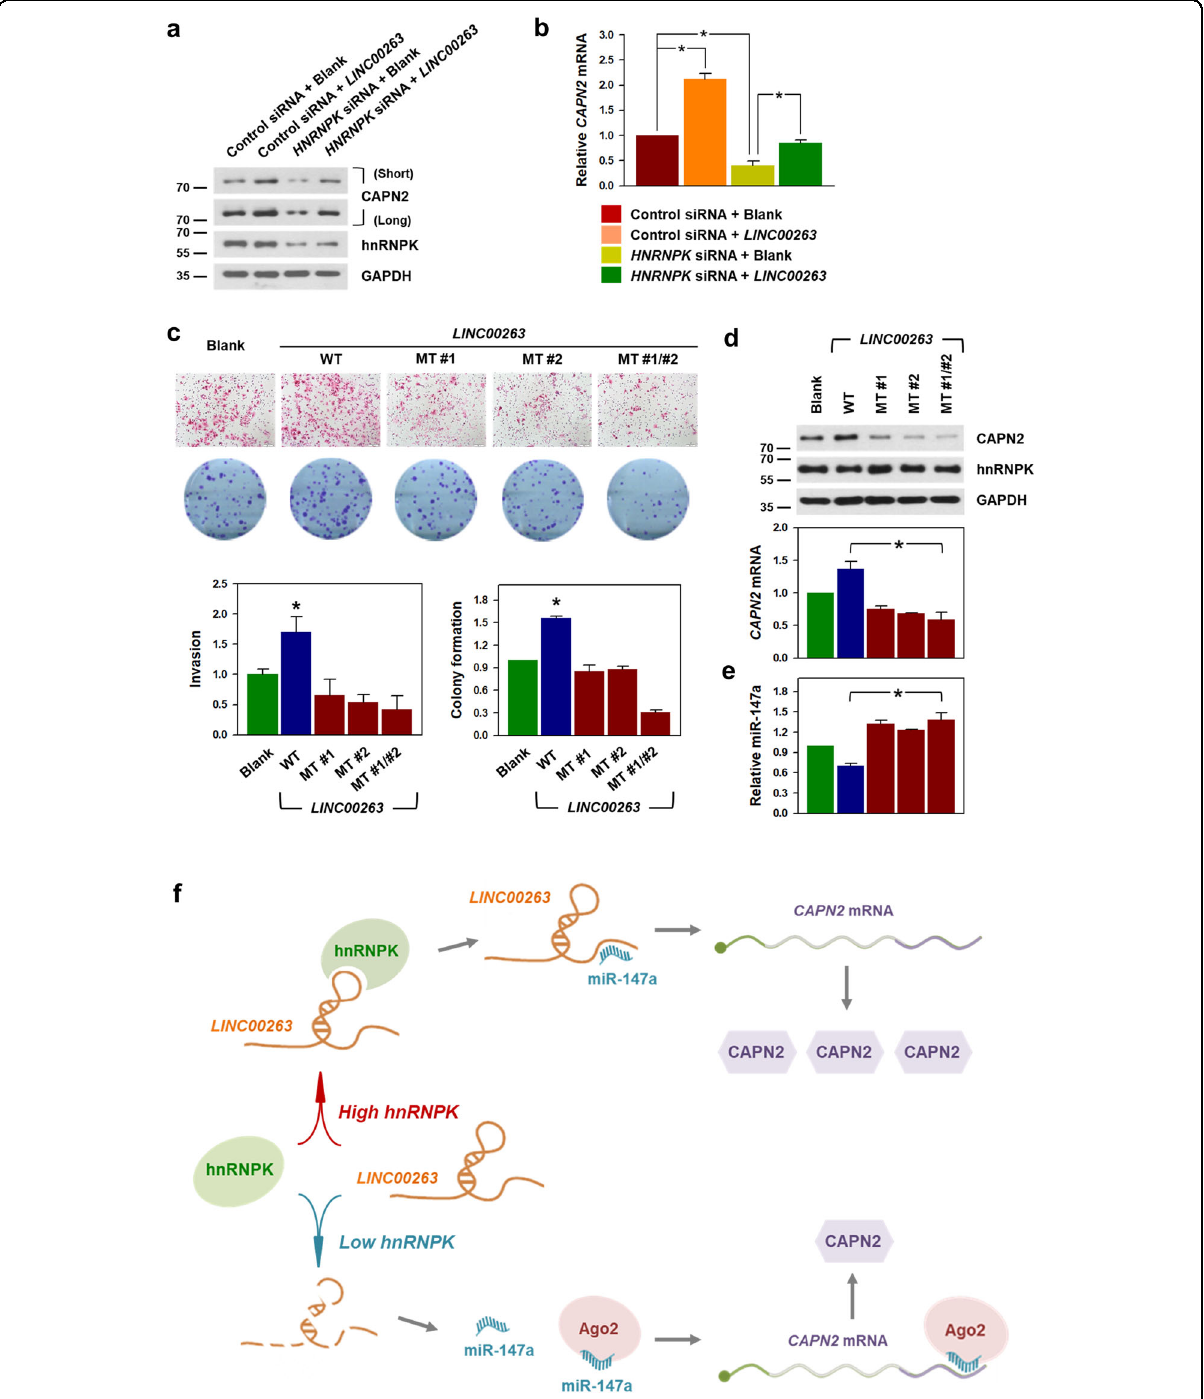
Fig. 7 The ability to sponge miR-147a is required for the oncogenic function of LINC00263 . a , b HeLa cells were transfected with HNRNPK siRNA and/or a LINC00263 expression vector. The expression levels of CAPN2 protein ( a ) and CAPN2 mRNA ( b ) were determined by Western blot and RT-qPCR analyses, respectively. c – e LINC00263 expression vectors harboring mutant sequences of both miR-147a MREs were constructed. As with constructing the luciferase reporter vectors, four nucleotides of each miR-147a MRE in LINC00263 were changed to block the binding of miR-147a. c The invasive and clonogenic effects of three mutated LINC00263 (miR-147a MRE mutant #1, #2, and #1/#2) were determined as described in “ Material and methods ” . d The expression levels of CAPN2 protein and CAPN2 mRNA were determined by Western blot and RT-qPCR analyses, respectively. e Effect of mutated LINC00263 on miR-147a expression was assessed by RT-qPCR. Statistical analyses were performed using the Student ’ s t test using three independent experiments (* p < 0.05). All data represent mean ± standard variation (SD). f Schematic of the proposed mechanism of action of the oncogenic hnRNPK/ LINC00263 /miR-147a/CAPN2-axis. A detailed description is shown in the main